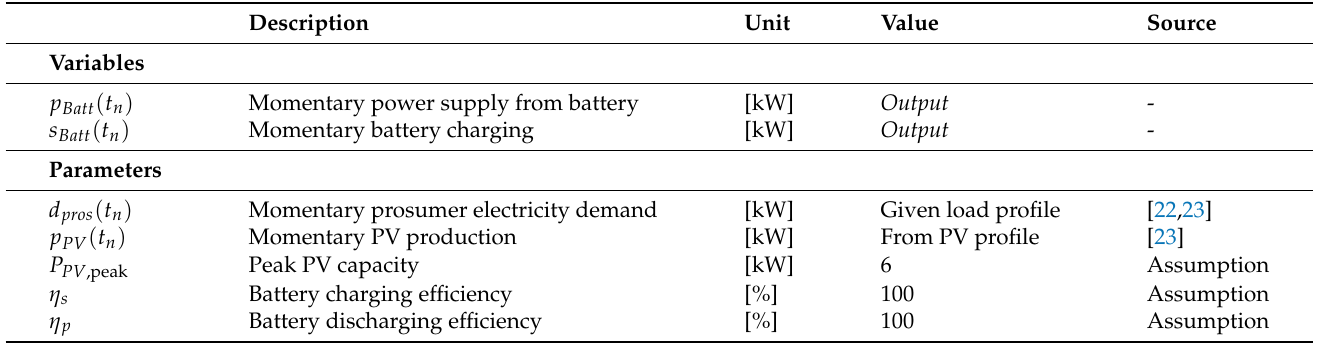
Table 3. Summary of the used variables and parameters for prosumer battery storage operation (battery operation mode 2).